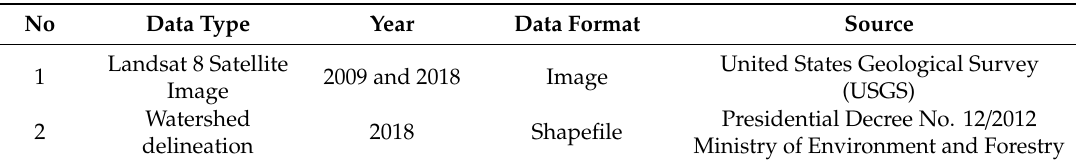
Table 2. Spatial Data Collection.